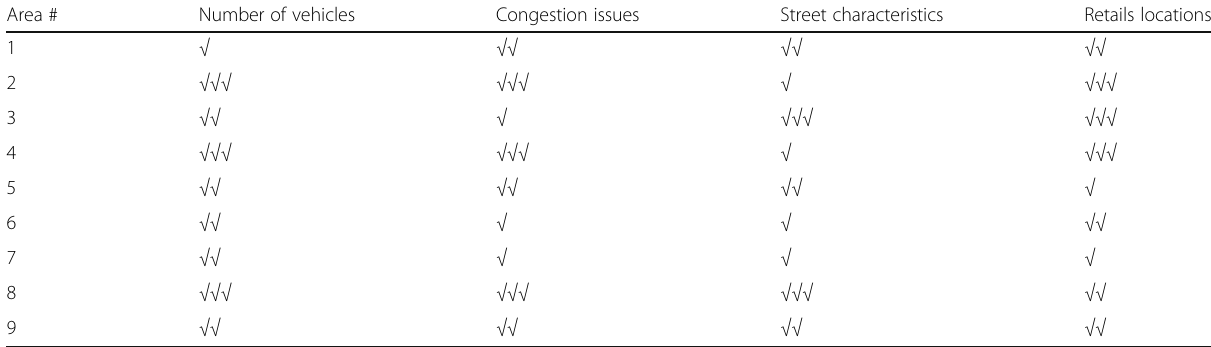
Table 1 Qualitative and quantitative evaluation of the four aspects of the nine areas Area # Number of